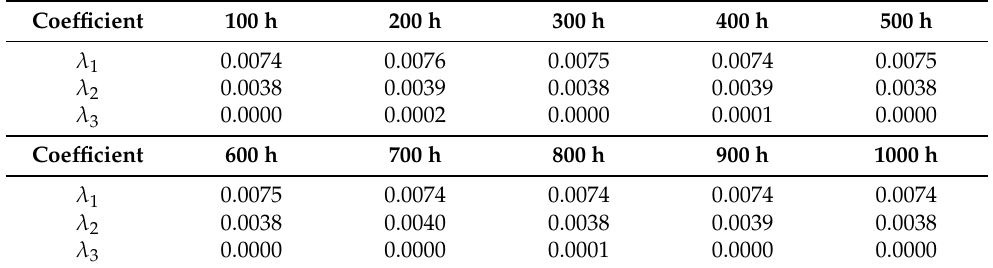
Table 3. The results of λ over